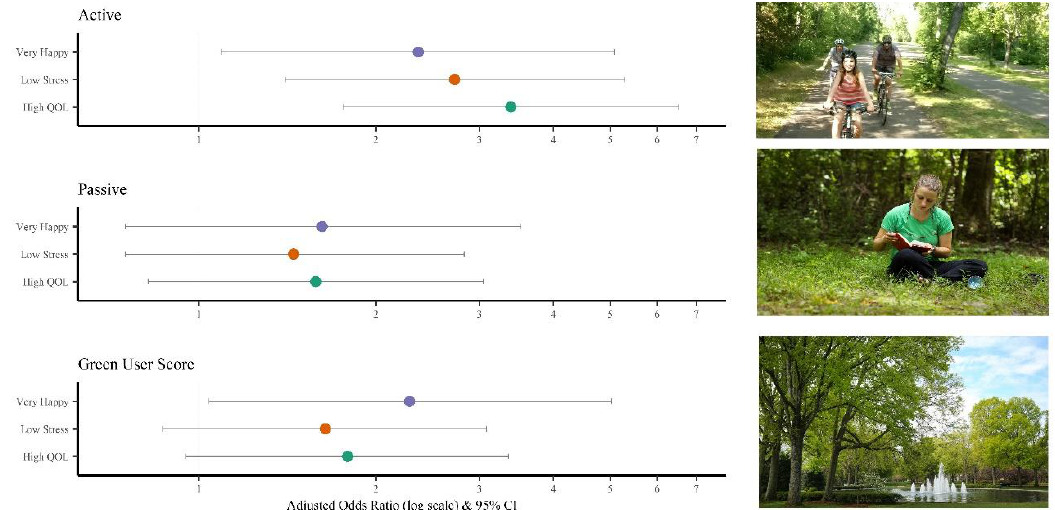
Figure 2. Adjusted † Odds Ratios (95% CIs) for measures of well-being associated with students’ Active Use of Green Space, Passive Use of Green Space, and Overall Green-User Score. ‡ Odds ratios are adjusted for gender and race and students’ perceived “busyness”; High Active Use = physically active for ≥ 15 min in an on-campus off-campus green space ≥ 4 times per week; High Passive Use = sit, study, or eat for ≥ 15 min in an on-campus or off-campus green space ≥ 4 times per week; High Green User Score = Score of ≥ 30 on overall green user scale measuring frequency of time spent in outdoor activities.